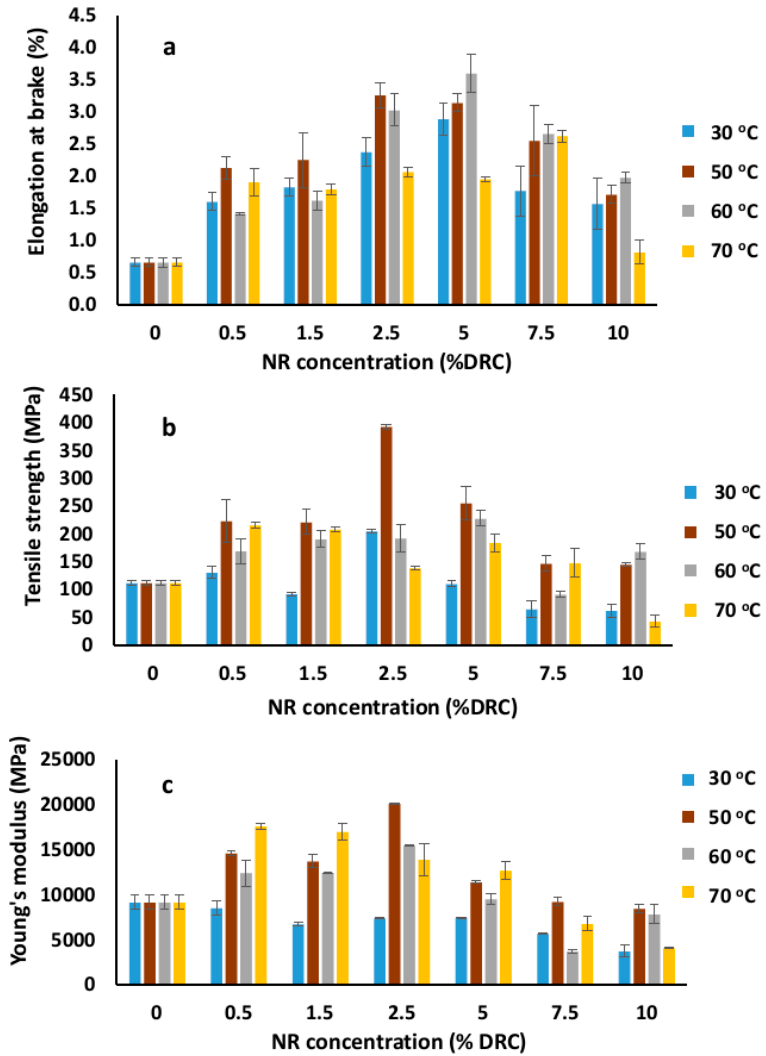
Figure 5. Elongation at break ( a ), tensile strength ( b ), and Young’s modulus ( c ) of the dried BC and NR–BC films modified by the immersion in NRL of various concentrations (0%–10% DRC) at various immersion temperatures.